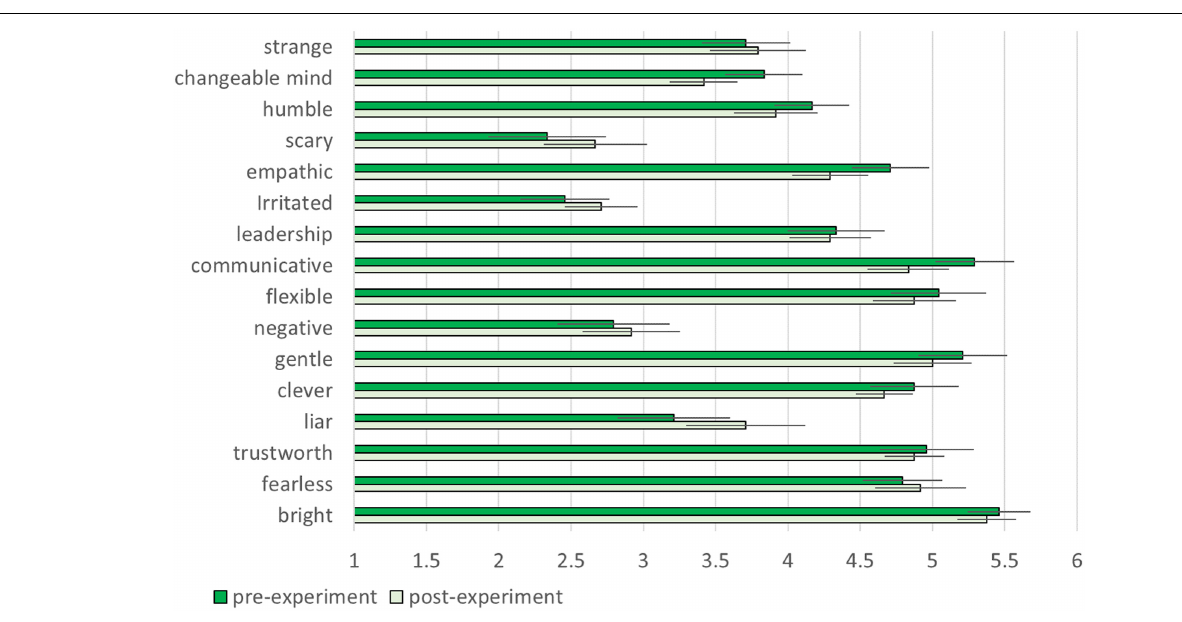
FIGURE 8 | Changes in participants’ impressions of other players in the control